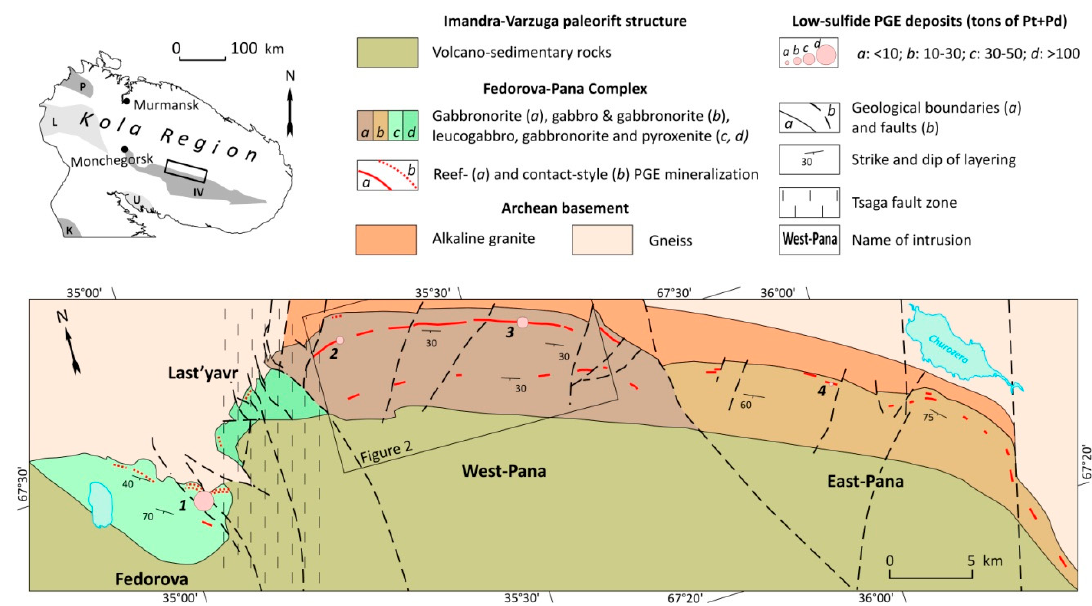
Figure 1. Simplified geological map of the Fedorova-Pana Complex, showing the location of low-sulfide PGE deposits ( 1 , Fedorova Tundra; 2 , North Kamennik; 3 , Kievey; 4 , East Chuarvy). Modified after [12]. Proterozoic structures of the predominantly Archean Kola Region (inset): Imandra-Varzuga (IV), Kuolajarvi (K), and Pechenga (P) paleorift structures; Lapland (L) and Umba (U) granulite belts.